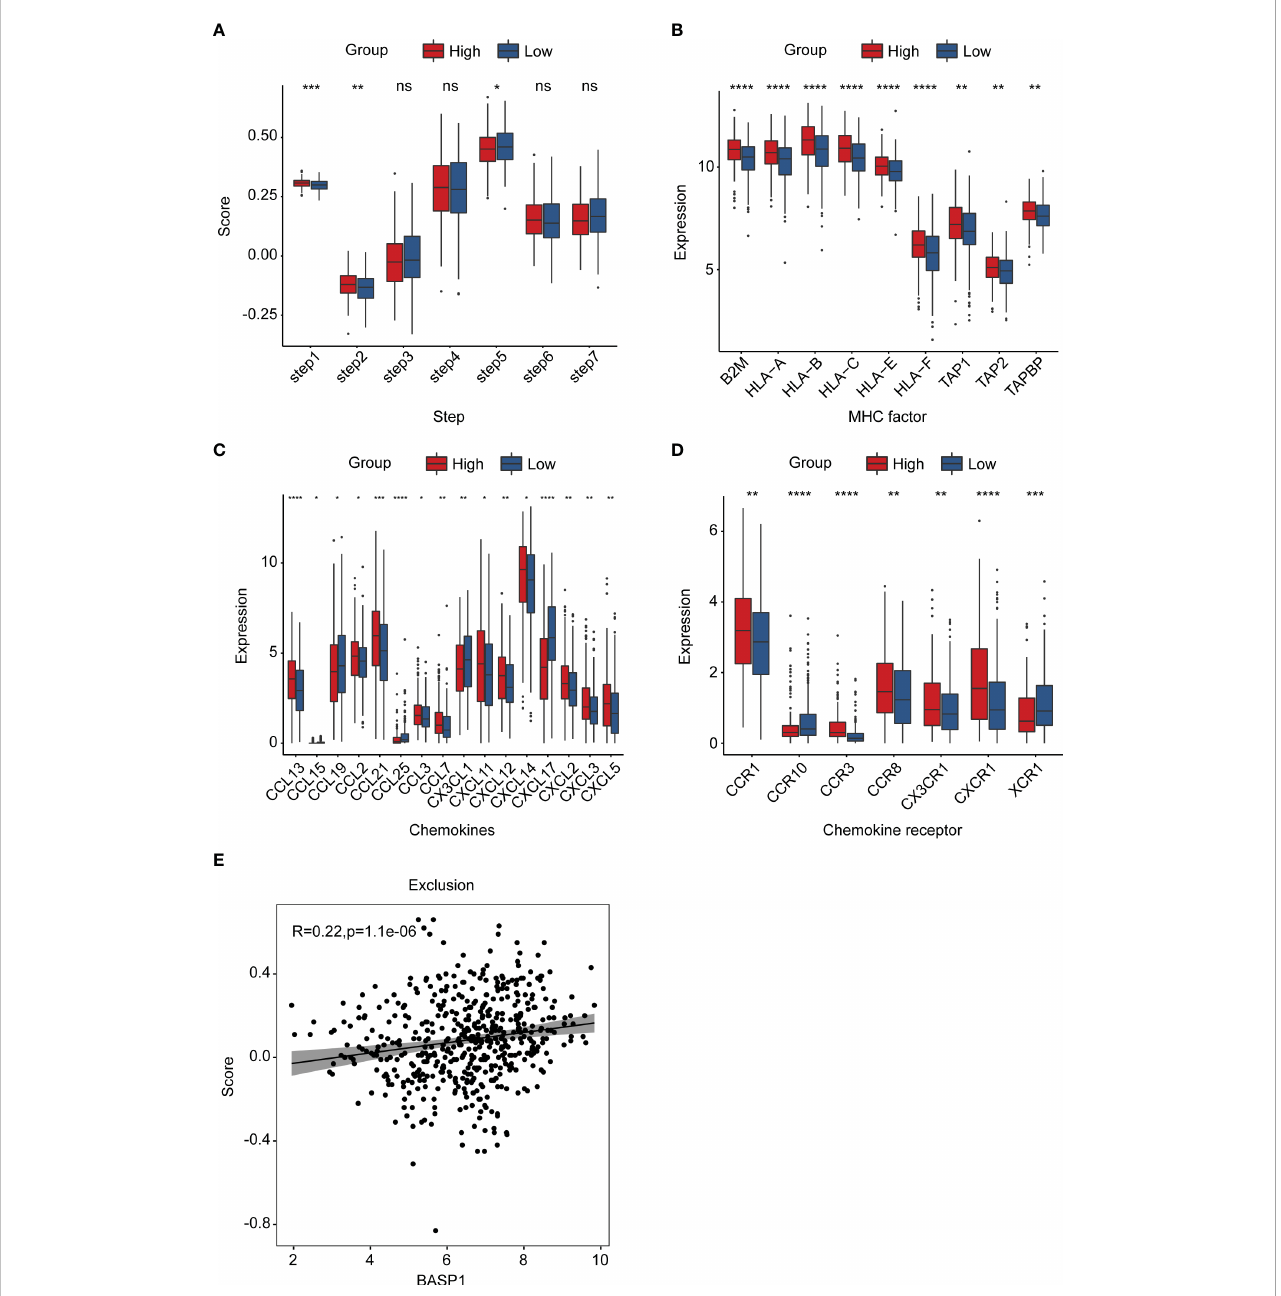
FIGURE 6 The landscape of BASP1 in the immunity cycle. (A) Characteristics of immune microcirculation in BASP1 high group and BASP1 low group. (B-D) Boxplot of the antigen-presenting molecule MHC (B) , chemokine (C) and chemokine receptor (D) . (E) The relationship between BASP1 expression and immune escape. * p < 0.05; ** p < 0.01; *** p < 0.001; **** p < 0.0001. ns, means no signi fi